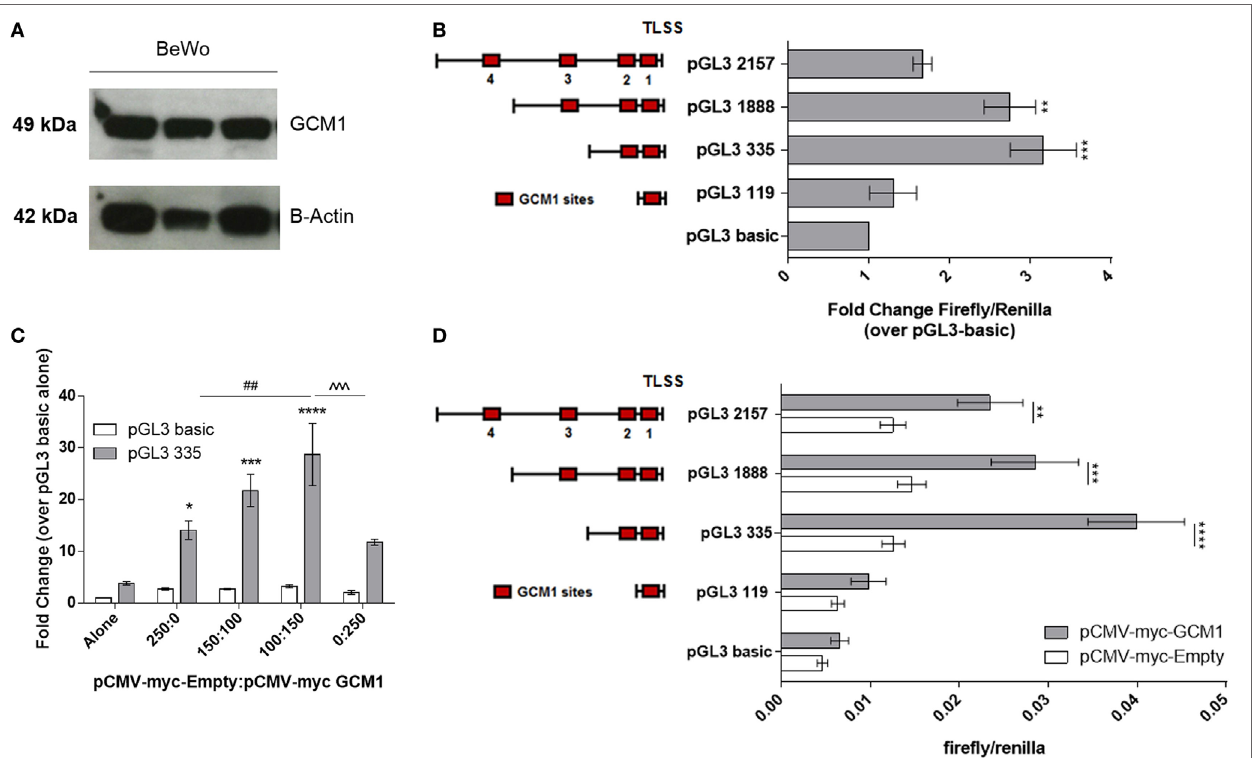
FigUre 2 | Glial cells missing 1 (GCM1) transactivates the LHB promoter. (a) Western blotting of protein extracted from human choriocarcinoma BeWo cells ( n = 3) using an antihuman GCM1 monoclonal antibody (c-terminal). β -actin was used as a loading control. (B) BeWo cells were transfected with specific lengths of the LHB promoter in a pGL3-basic luciferase reporter vector ( n = 3). Activity of promoter constructs was expressed as fold-change firefly/renilla compared to pGL3-basic. ** p < 0.01, *** p < 0.001 (one-way ANOVA). (c) pGL3-basic and pGL3-335 were co-transfected with ratios of pCMV-myc-Empty: pCMV-myc-GCM1 to assess ability of GCM1 to drive promoter activity in COS7 cells ( n = 3). * p < 0.05, *** p < 0.001, **** p < 0.0001 relative to pGL3-335 alone, ## p < 0.01 relative to pGL3-335 + 250 ng pCMV-myc-Empty, ^^^ p < 0.001 relative to pGGl-335 + 150 ng pCMV-myc-GCM1 (two-way ANOVA). (D) Specific lengths of the LHB promoter were transfected with 150 ng of empty pCMV-myc-Empty vector, or with 150 ng of pCMV-myc-GCM1 ( n = 4). * p < 0.05, ** p < 0.0.01, *** p < 0.001, **** p < 0.0001 (two-way